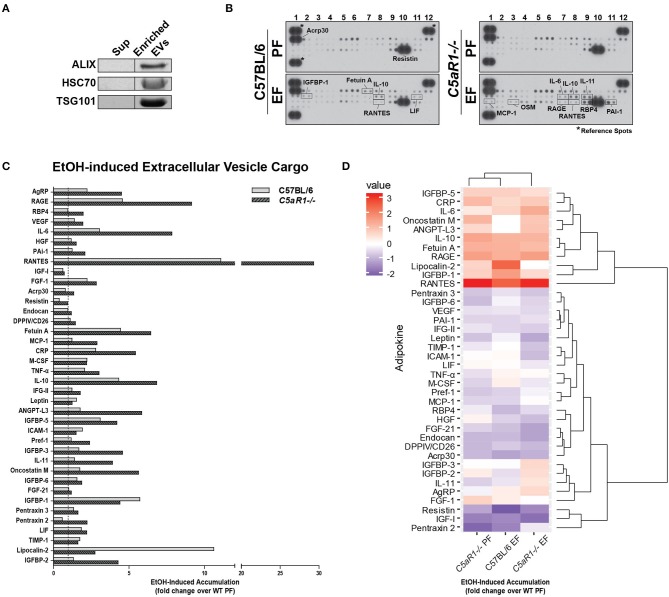
Ethanol and C5aR1 differentially modulate adipocyte-derived EV cargo. WT and C5aR1−/− mice were allowed free access to ethanol (32%, d25) or pair-fed control diets. Adipocytes were isolated following collagenase digestion. Adipocyte-derived EVs were isolated from supernatants (120 min post-isolation) using PEG 8000-based precipitation. (A) EV content was prepared and proteins separated by SDS-PAGE. ALIX, HSC70, and TGS101 were measured by Western blot. (B) EV cargo was assessed using an adipokine array. Relative density was calculated using Image J; data were normalized to reference spots for each experimental group. Lighter exposures were used for more abundant adipokines (Acrp30, Resistin) and reference spots (data not shown). (C) Ethanol-fed groups are expressed as fold change of WT pair-fed EV cargo. (D) Heat maps illustrate changes in adipocyte-derived EV cargo between groups (least abundant = dark blue; most abundant = red); data are expressed as fold change of WT pair-fed EV cargo. Hierarchical clustering (shown at the right of the heat map) revealed the similarities between treatment and genotype. Data are representative of pooled samples (n = 6–8) for each group. PF, pair-fed; EF, ethanol-fed.